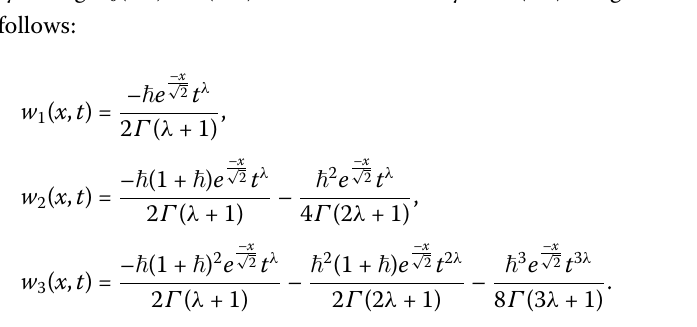
– x √ 2 and the system (4.6), we get the subsequent